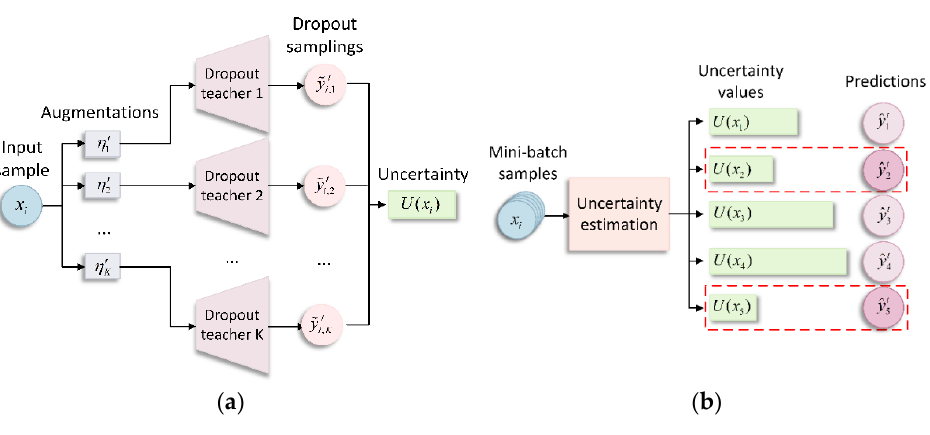
Figure 4. Certainty driven selection method: ( a ) uncertainty estimation; ( b ) predictions selection based on certainty.